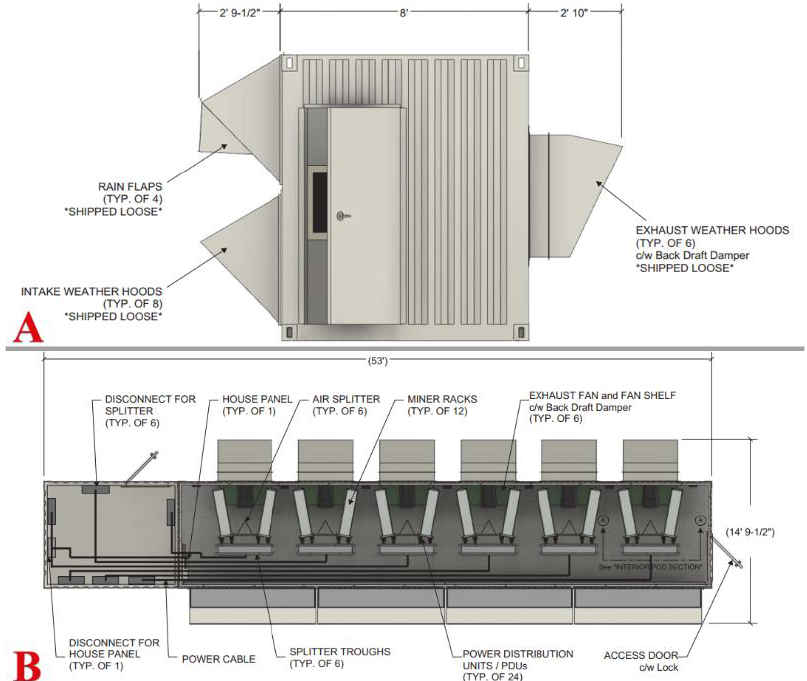
Figure 4. The MightyPOD Prefabricated commercial cryptocurrency mining container from Bit-Ram. This represents the schematic drawing of the MightyPOD container designed to support 408 Antimer S17es. Label ( A ) denotes the access side view, and label ( B ) denotes the mining container from a top view [60].